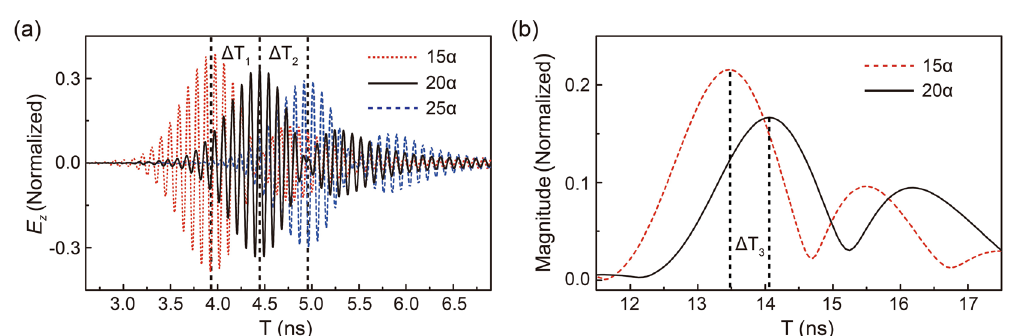
Figure 5. ( a ) Simulated temporal signals with Gaussian pulse incidence through DZI PCs with different thicknesses. ( b ) Experimental measured temporal signals through DZI PCs with different